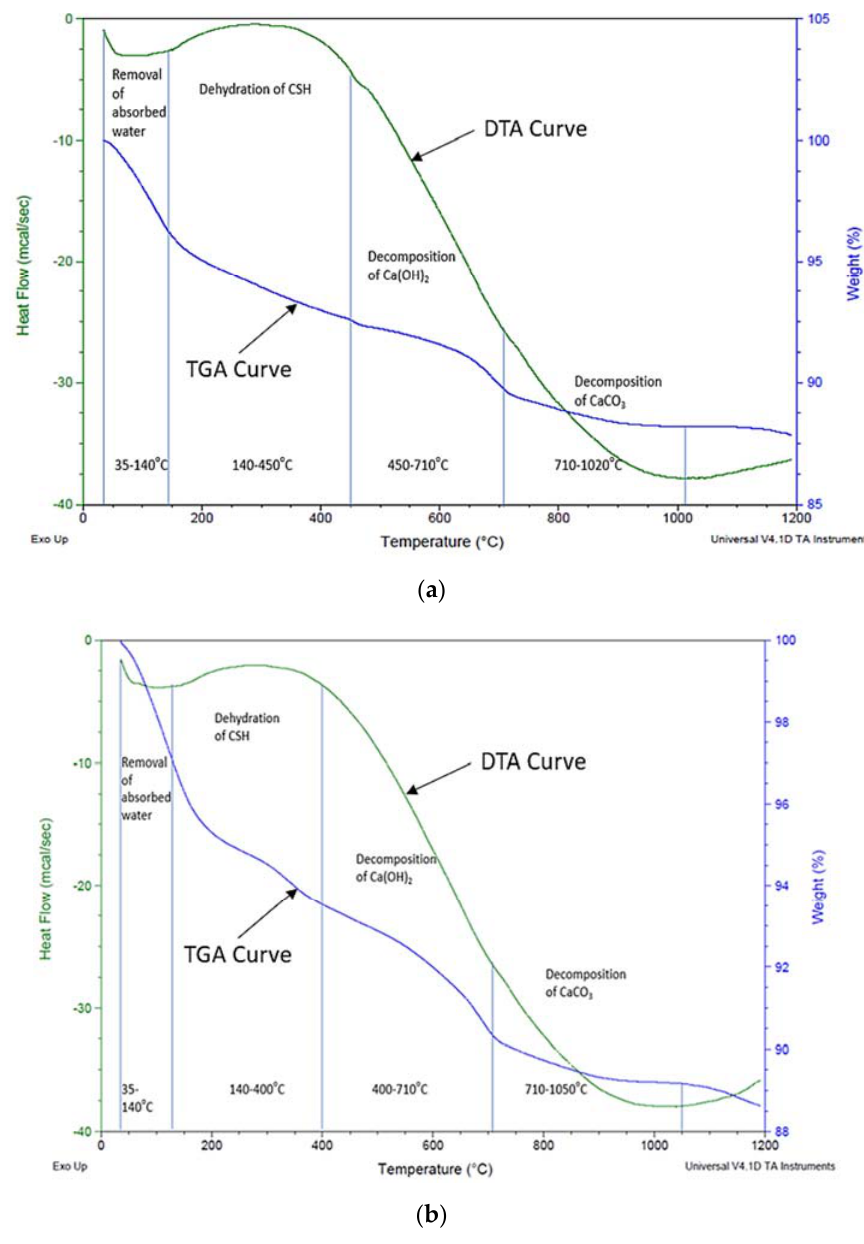
Figure 11. Thermal Analysis of mortar incorporating Silica Fume and Rice Husk Ash. ( a ) C ‐ 5S ‐ 20R, ( b ) C ‐ 10S ‐ 5. ( b )